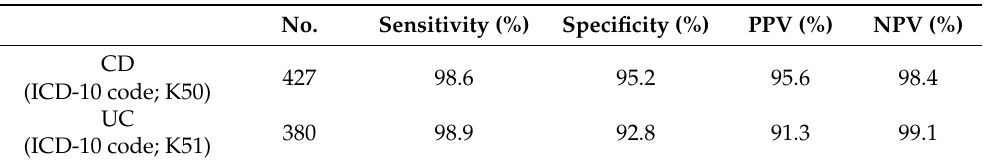
Table 4. ICD-10 code performance using Algorithm 4 to identify CD and UC patients in the sub- group